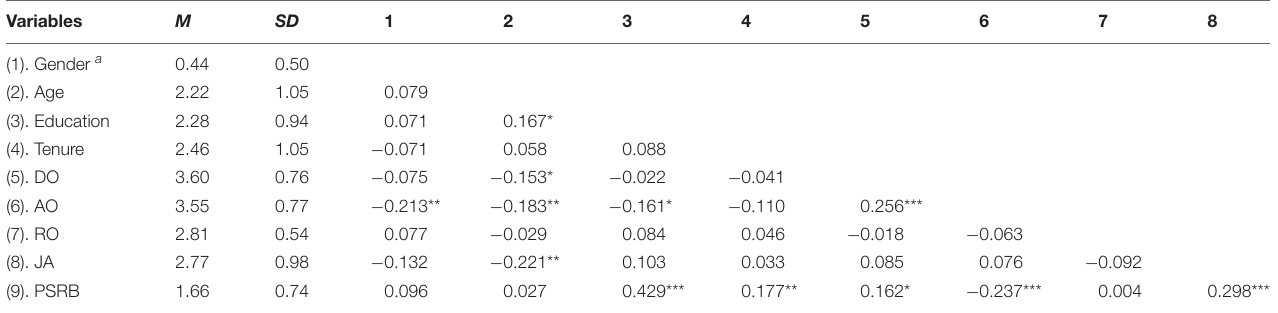
TABLE 2 | Descriptive statistics and correlations for study variables.